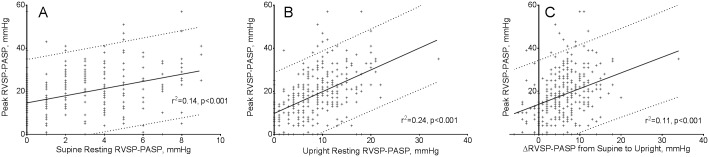
Relationships between supine and upright resting right ventricular outflow tract (RVOT) gradient and peak exercise RVOT gradient.Scatterplots of peak RVOT pressure gradient (i.e., RVSP-PASP) versus supine resting RVOT gradient (Panel A), upright resting RVOT gradient (Panel B), and the change in RVOT pressure gradient between from supine to upright positions at rest (Panel C). In the small subset of cases where resting RVSP-PASP was negative, the gradient was set to 0 mmHg. PASP—pulmonary artery systolic pressure; RVSP—right ventricular systolic pressure.